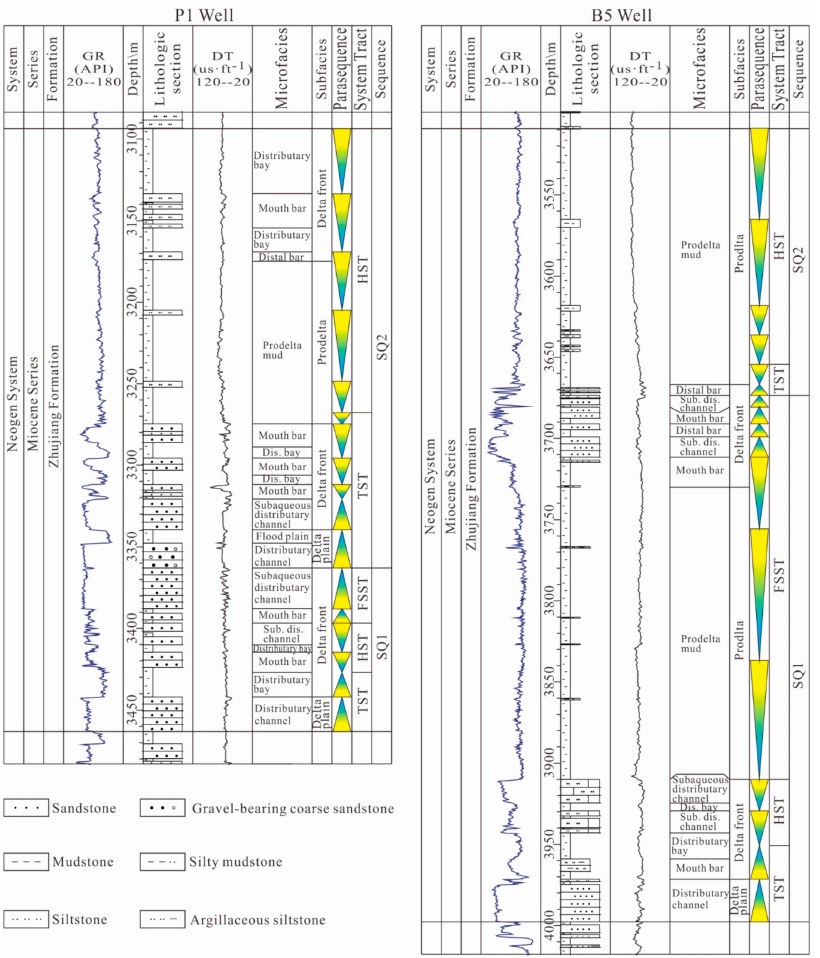
Figure 4. Sedimentary facies and sequence stratigraphy characteristic of single well in Zhujiang Formation of Panyu low uplift and Baiyun sag, Pearl River Mouth Basin. Note that Well P1 is above the shelf break at 21 Ma and landward, the Well B5 is below the shelf break at 21 Ma and